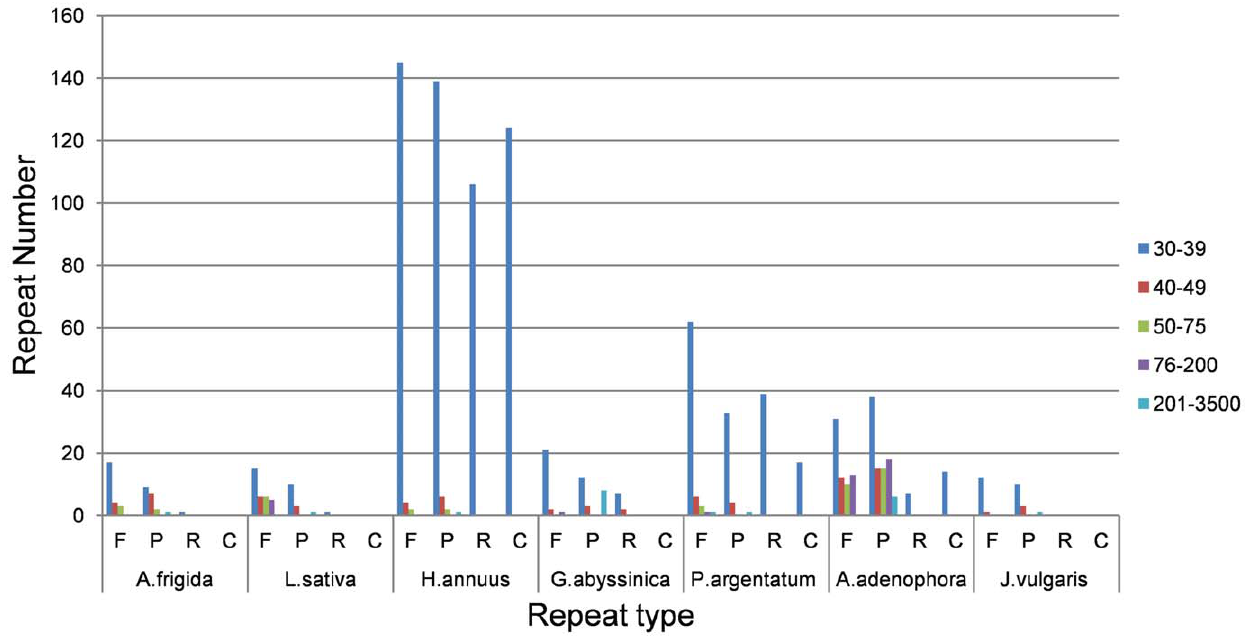
Figure 5. Repeat sequence analysis in seven sequenced Asteraceae chloroplast genomes. REPuter was used to identify repeat sequences with length $ 30 bp long and sequence identity $ 90% in the cp genomes. F, P, R, and C indicate that the repeats matching in forward, palindrome, reverse, and complement orientations, respectively. Different repeat unit lengths are indicted with different color.